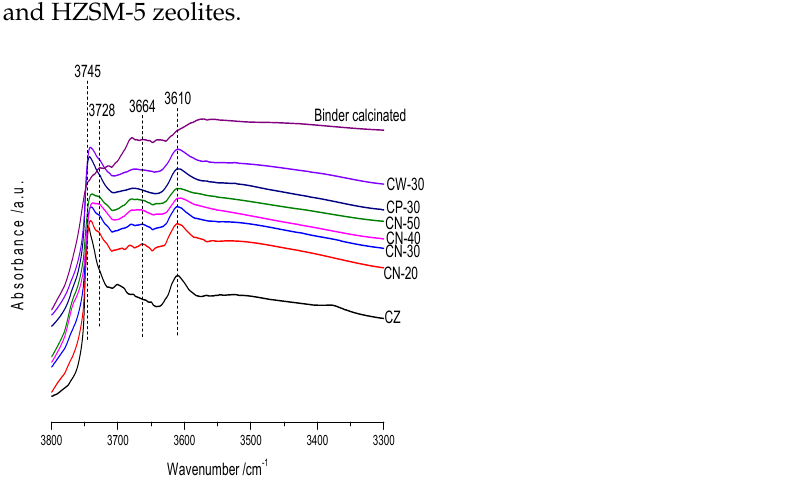
Figure 10. FT-IR spectra of the catalysts’ surface O-H stretching Figure 10. FT ‐ IR spectra of the catalysts’ surface O ‐ H stretching vibrations. The element distribution results of the catalysts from SEM ‐ EDS are shown in Figure 11 and Table 3. With an increase in binder content the aluminum content increases, and the silicon content first increases and then decreases. The aluminum content of CN ‐ 30 and CW ‐ 30 is close, about 9.4%. The aluminum content of CP ‐ 30 is less, and the silicon content of CP ‐ 30 and CW ‐ 30 is higher than CN ‐ 20. They show that the binder and HZSM ‐ 5 distribution of CN ‐ 30 is relatively uniform.